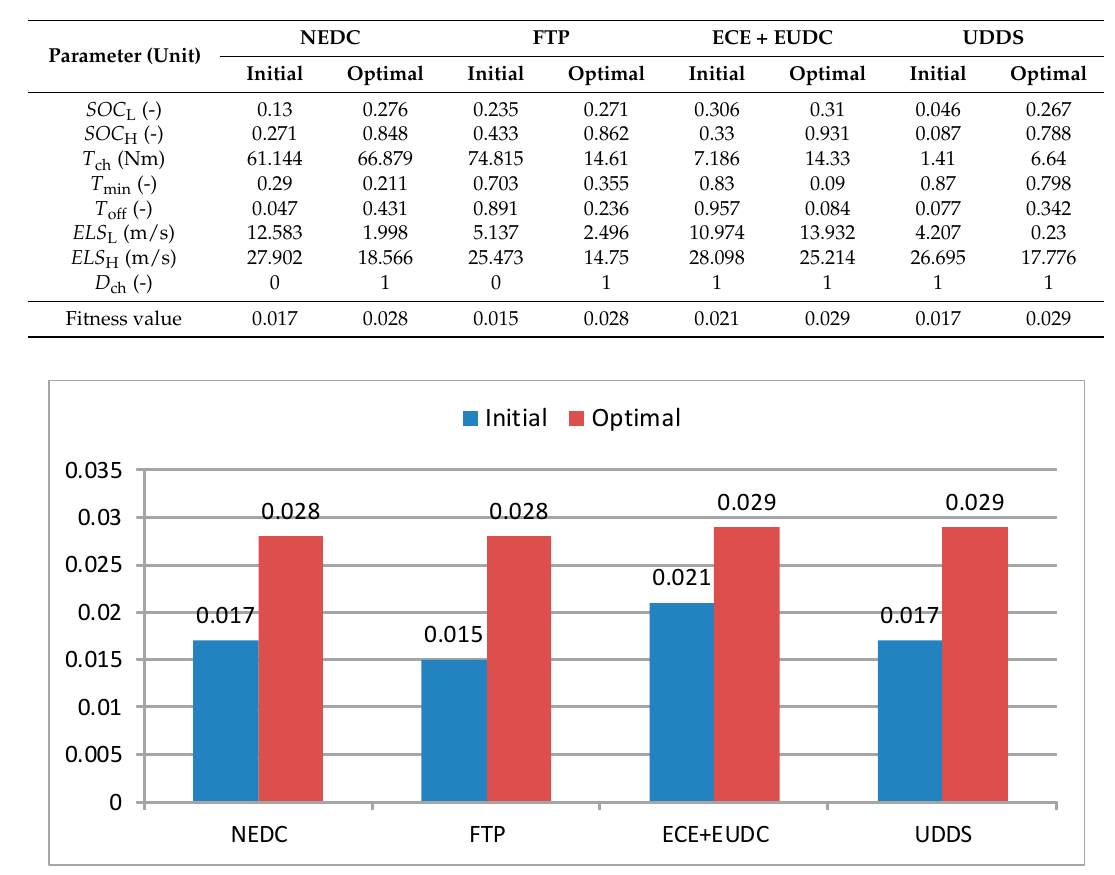
Table 7. The initial values and optimal values of the parameters of the control strategy.